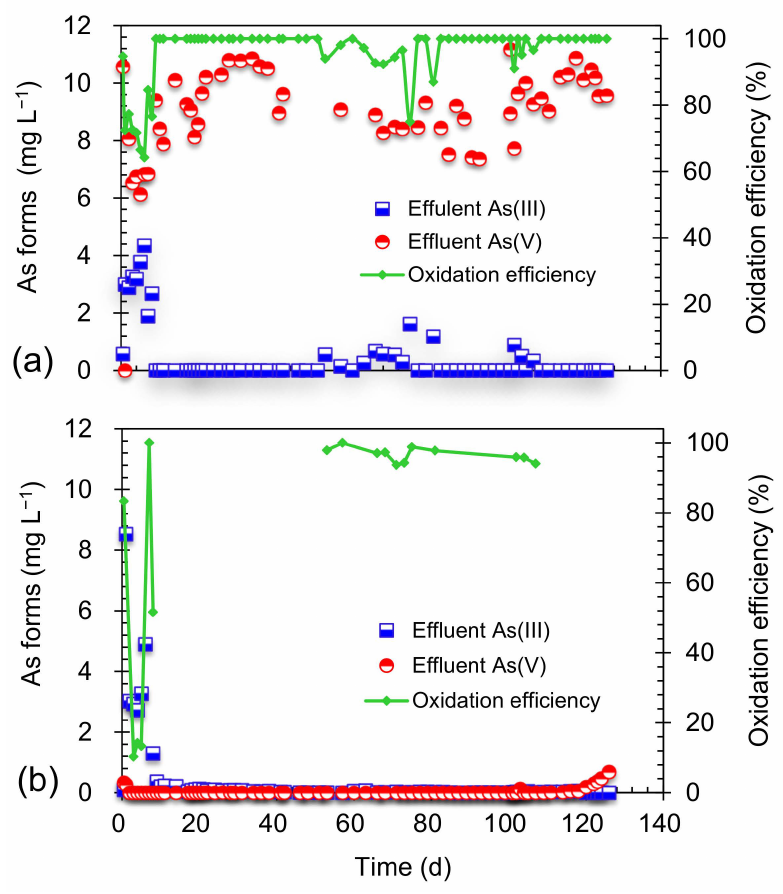
Figure 3. As(III) oxidation in R1 ( a ) and R2 ( b